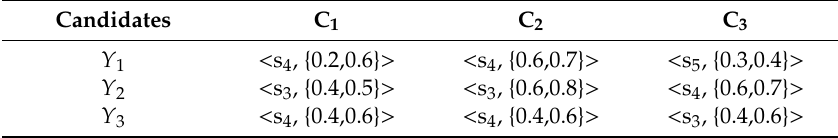
Table 17. Hesitant fuzzy linguistic stochastic decision matrix (under state H 2 ) H 2 ( P 2 =